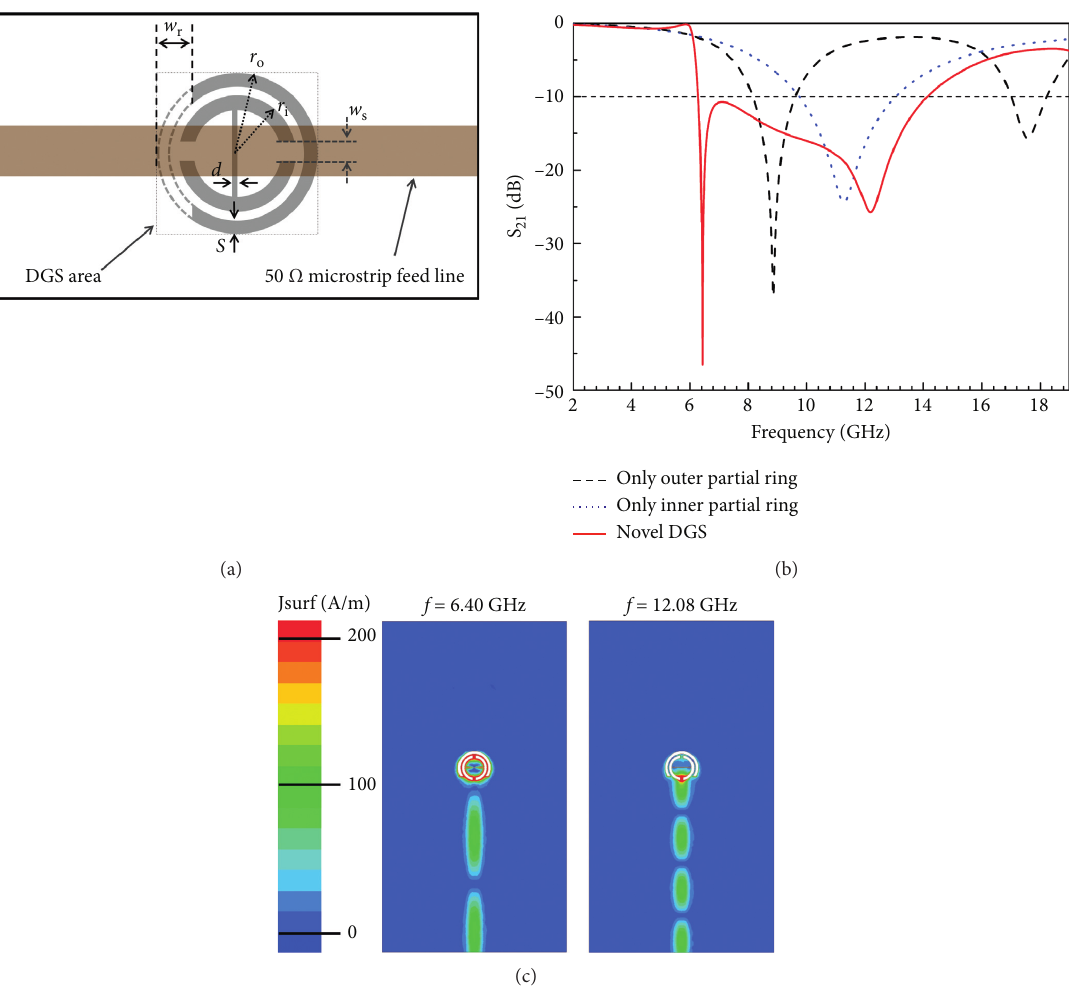
Figure 5: (a) Structural diagram of the novel DGS below the 50 Ω microstrip feed line. (b) Simulated S partial ring, and novel DGS below the 50 Ω microstrip feed line. (c) Simulated current distributions at the two resonance peaks of novel DGS.